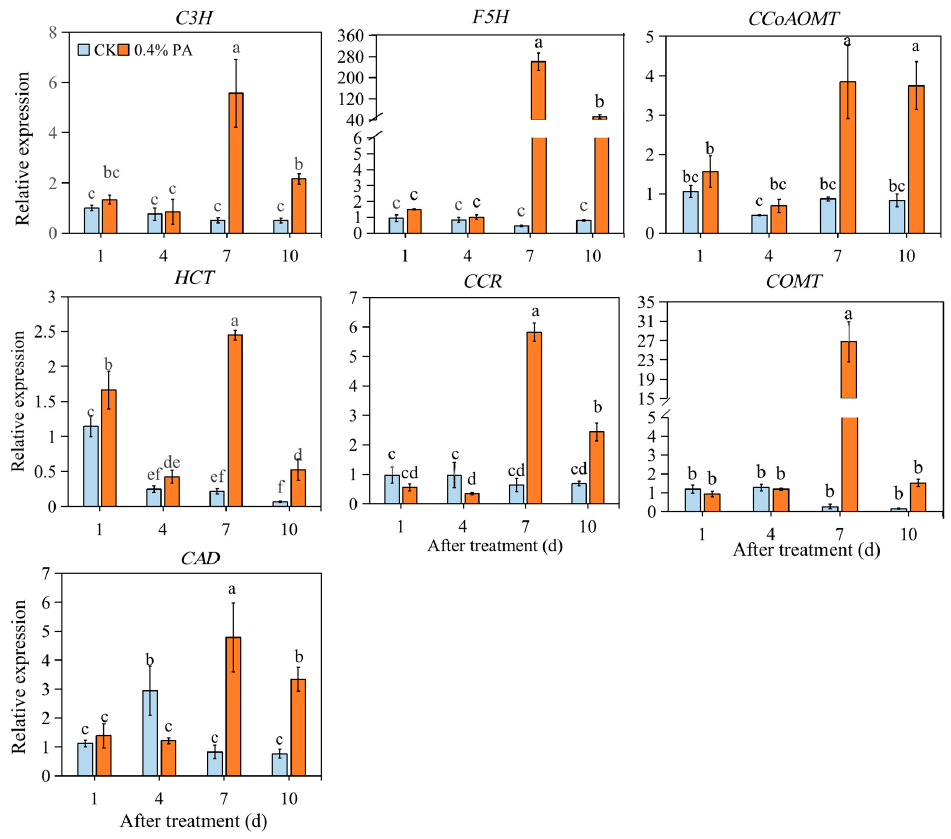
Figure 6. Relative transcript levels of lignin biosynthetic genes under 0.4% PA treatment. C3H : coumarate 3-hydroxylase; F5H : ferulate 5-hydroxylase; CCoAOMT : caffeoyl CoA O-methyl trans- ferase; HCT : shikimate O-hydroxycinnamoyl transferase; CAD : cinnamyl alcohol dehydrogenase; CCR : cinnamoyl CoA reductase; COMT : caffeic acid O-methyltransferase. The data are presented as mean values ± standard deviation; the lowercase letters above the bars indicate significant difference at p ≤ 0.05